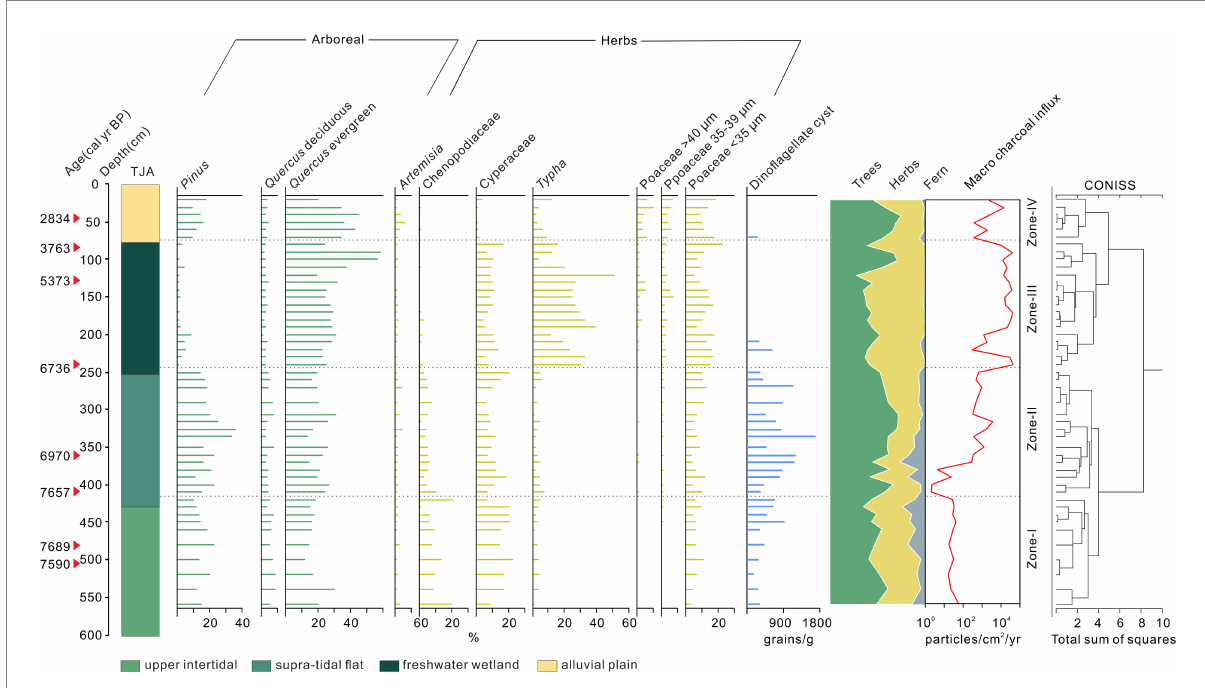
FIGURE 5 Assemblages of selected pollen species, concentration of dinoflagellates and variation of macro charcoal influx of TJA.